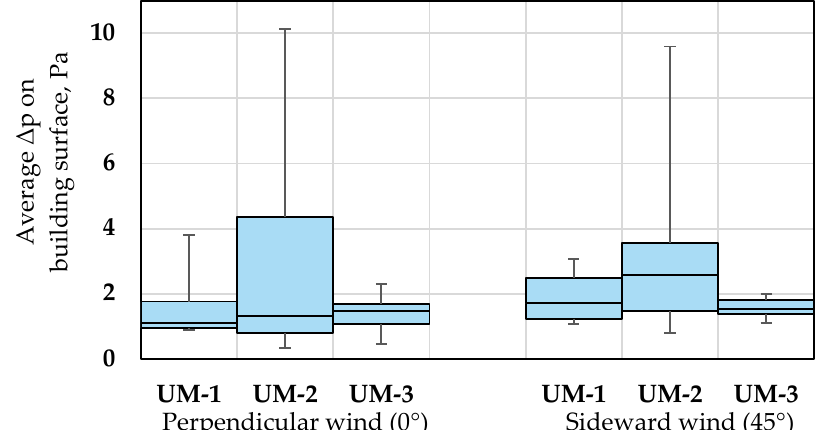
Figure 3. Pressure difference (Δp) distribution on building surfaces for urban morphologies UM-1, UM-2, UM-3 and two wind directions (0° and 45°). Horizontal lines within bars indicate median values, bars denote inter-quartile ranges and whiskers define the full range of values. Table 2. Results of air infiltration and expected impact on energy consumption calculations.